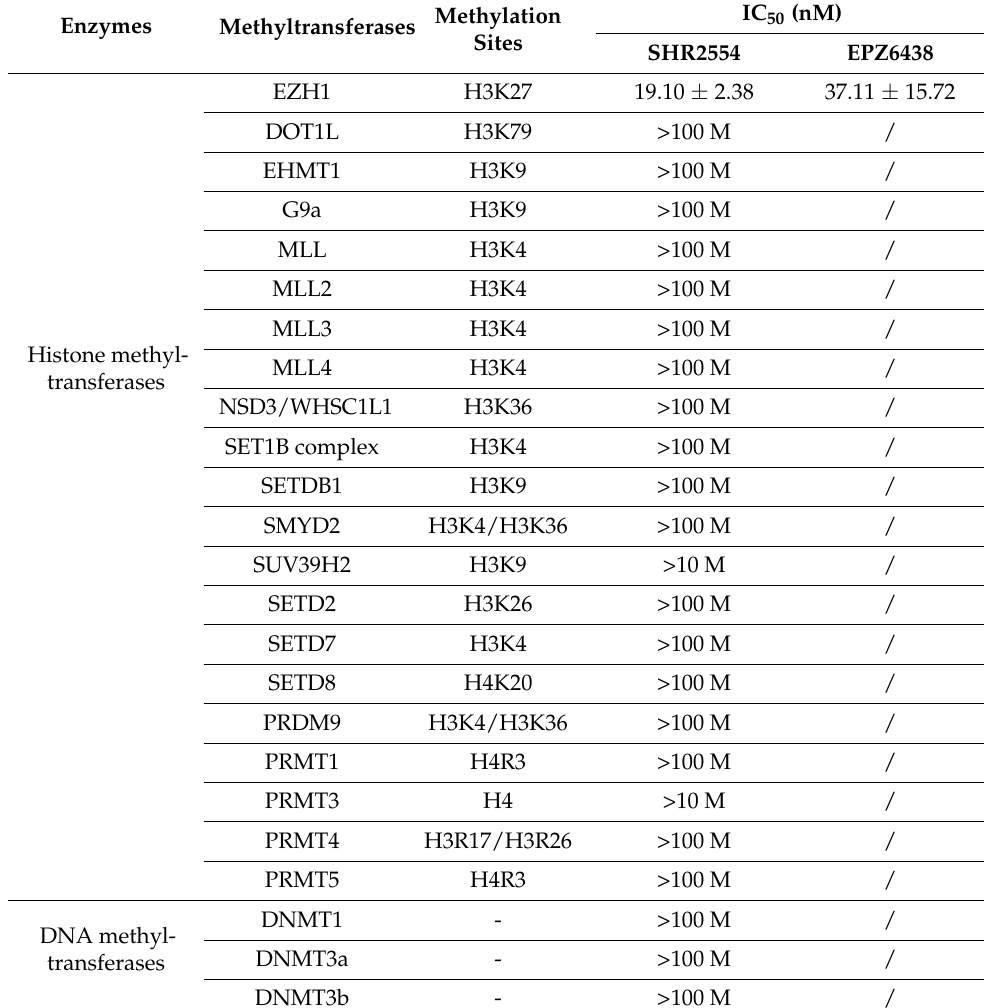
Table 3. Selectivity analysis of SHR2554 in a panel of